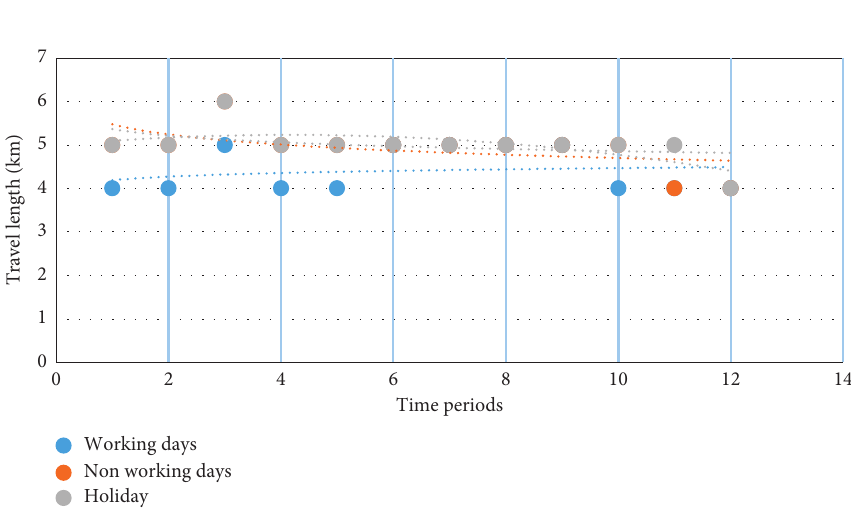
Figure 5: Driver selection decision scheme in different periods. Table 13: Passengers arriving at the loading area within unit time of an airport in different periods. Observing